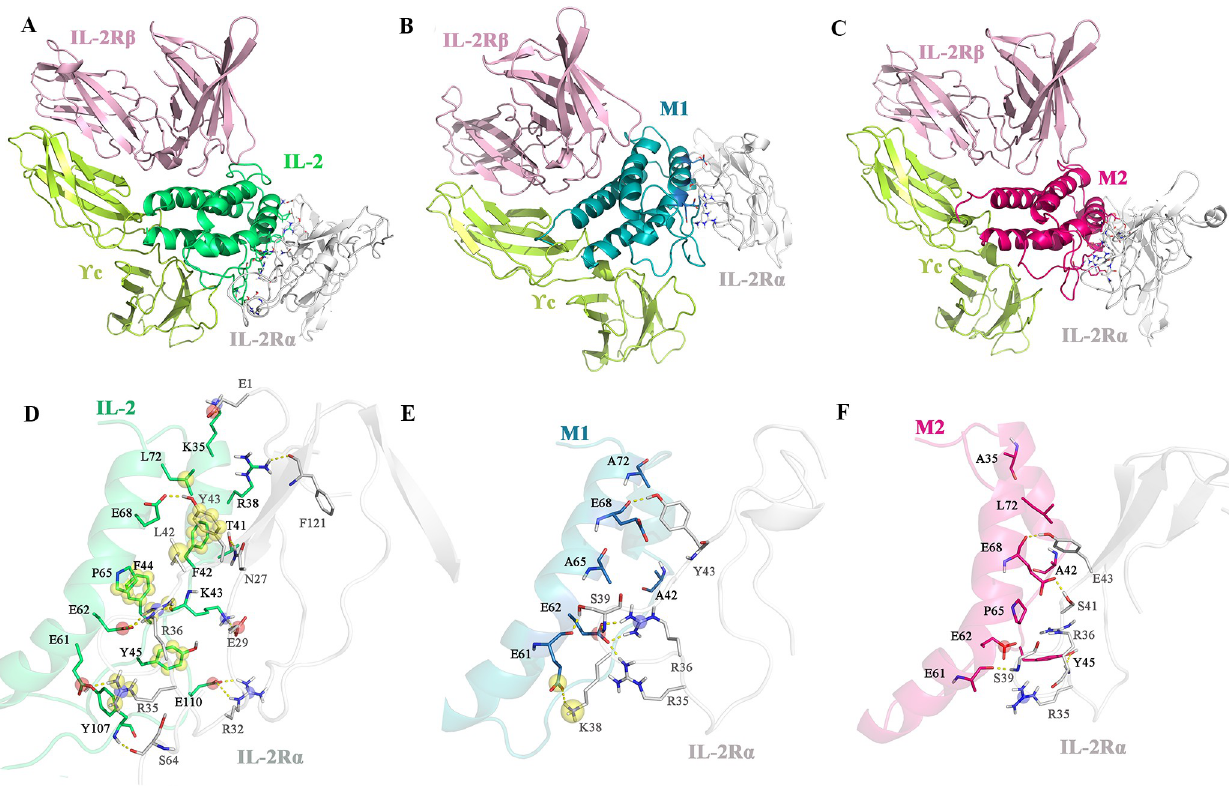
Fig 4. Interactions between A. wtIL-2 and IL-2R αβγ c, B. M1 and IL-2R αβγ c, and C. M2. IL-2R αβγ c after 100 ns of MDs, as well as the close view of D. wtIL-2 and IL-2R α interactions, E. M1 and IL-2R α and F. M2 and IL-2R α . The hydrogen bonds are shown in yellow dashes. The red and blue spheres represent charging interactions (salt bridges), and the yellow spheres represent electrostatic (like π - π , alkyl- π and π -cation) interactions.